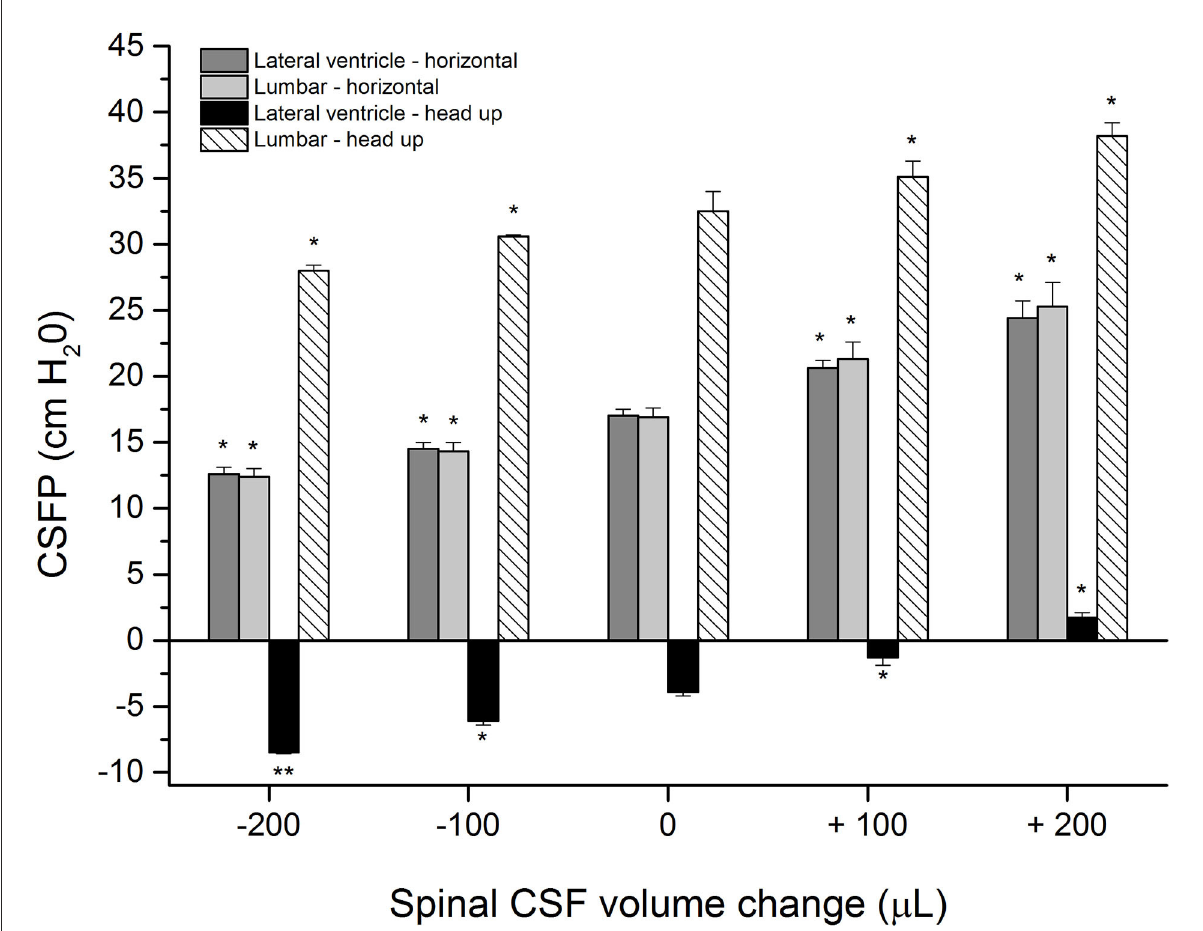
FIGURE2 CSFP changes (cm H 2 O) in anesthetized cats in horizontal-0 ◦ (lateral ventricle-horizontal and lumbar-horizontal) and head-up 90 ◦ (vertical) body position inside the lateral ventricle (lateral ventricle-head-up) and in the lumbar subarachnoid space at L3 level (lumbar-head-up) in control condition (0 µ L; n = 4), after addition ( + ) of 100 and 200 µ L of artificial CSF into the lumbar space ( n = 4) and after extraction (-) of 100 or 200 µ L from the lumbar space ( n = 4). Columns represent mean measurement values, while vertical lines represent standard errors of the mean values. There is a statistically significant difference between CSF pressure in the control condition and after adding/removal of fluid volume, * p < 0.05;** p <